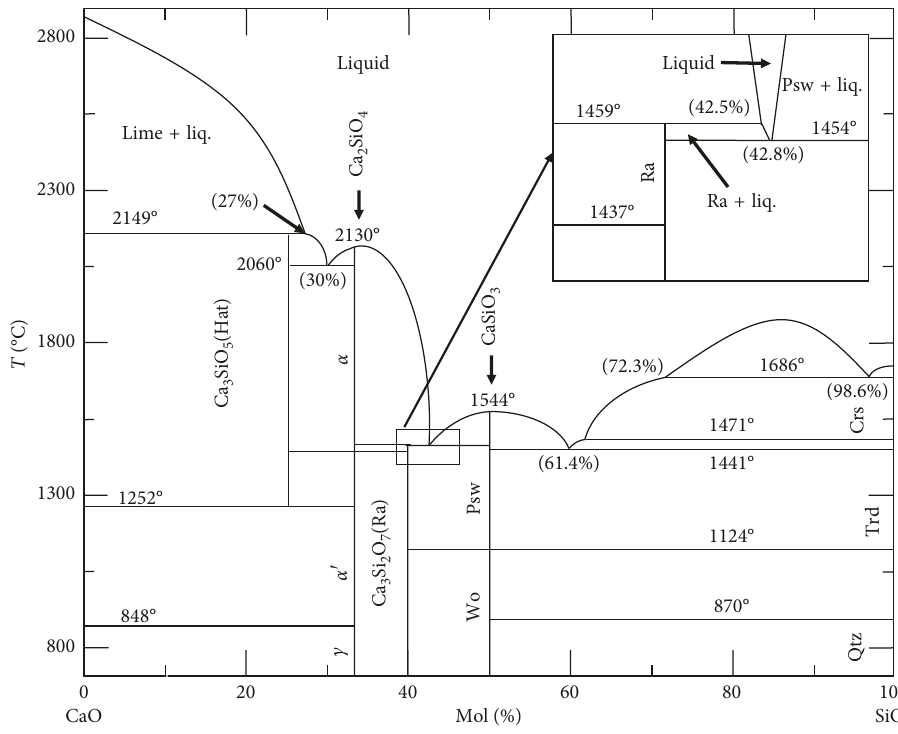
Figure 3: The CaO-SiO 2 phase diagram by Huang (1995)